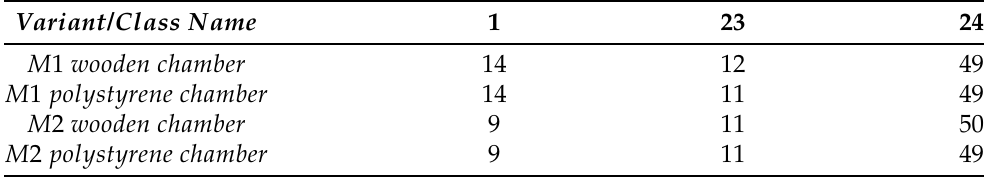
Table 2. Size of decision classes in the tested